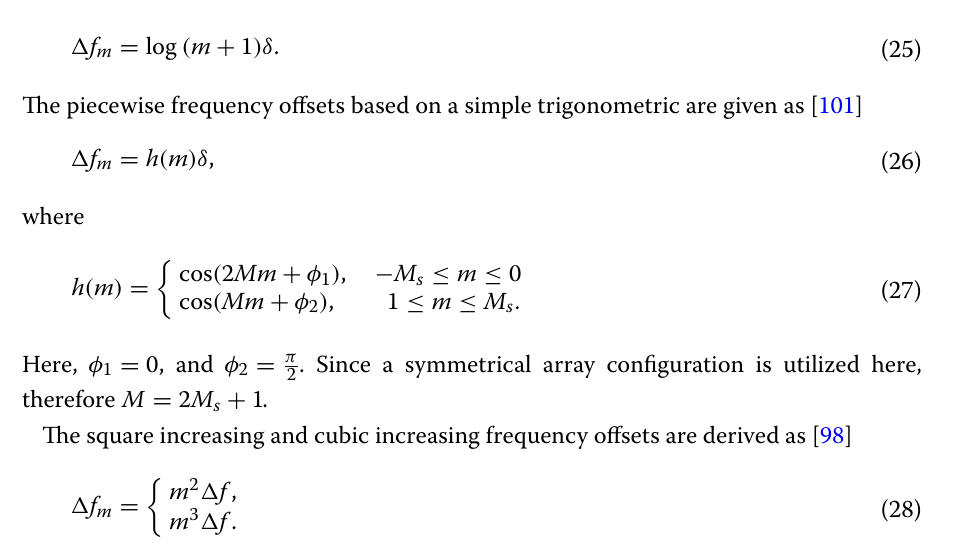
π Here, φ 1 = 0 , and φ 2 = 2 . Since a symmetrical array configuration is utilized here, therefore M = 2 M s + 1